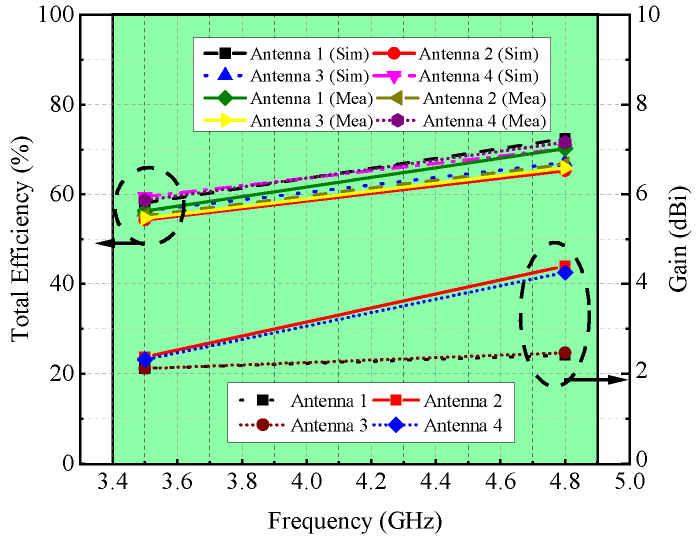
Figure 9. Gain and efficiency of MIMO